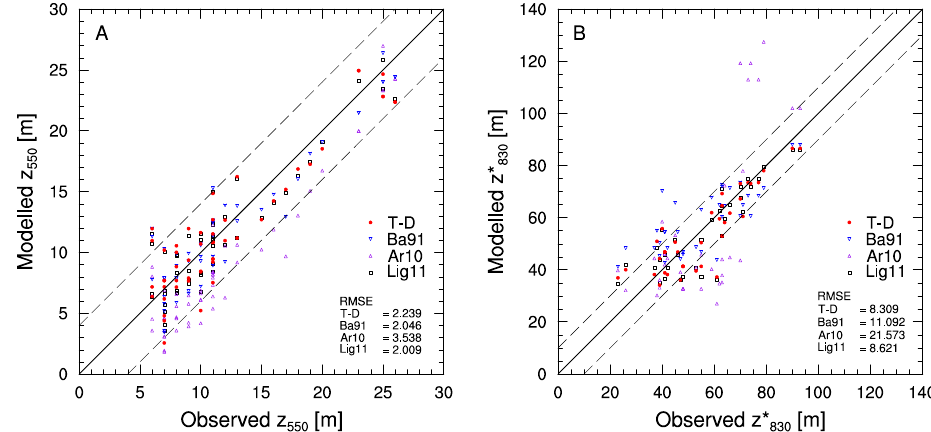
Figure 3. Comparison of observed and modeled depths of two critical density levels: 550kgm − 3 (a) and 830kgm − 3 . Observed depths are from 48 firn cores across the Antarctic ice sheet (Van den Broeke, 2008), and model simulations from the steady-state models of Barnola et al. (1991) (Ba91, blue downward triangle), Arthern et al. (2010) (Ar10, purple upward triangle) and Ligtenberg et al. (2011) (Lig11, black square) and the time-dependent simulation used here (red filled circles) are shown. Note that z ∗ 830kgm − 3 density level and not the true depth of the z 830 (same as in Ligtenberg et al.,